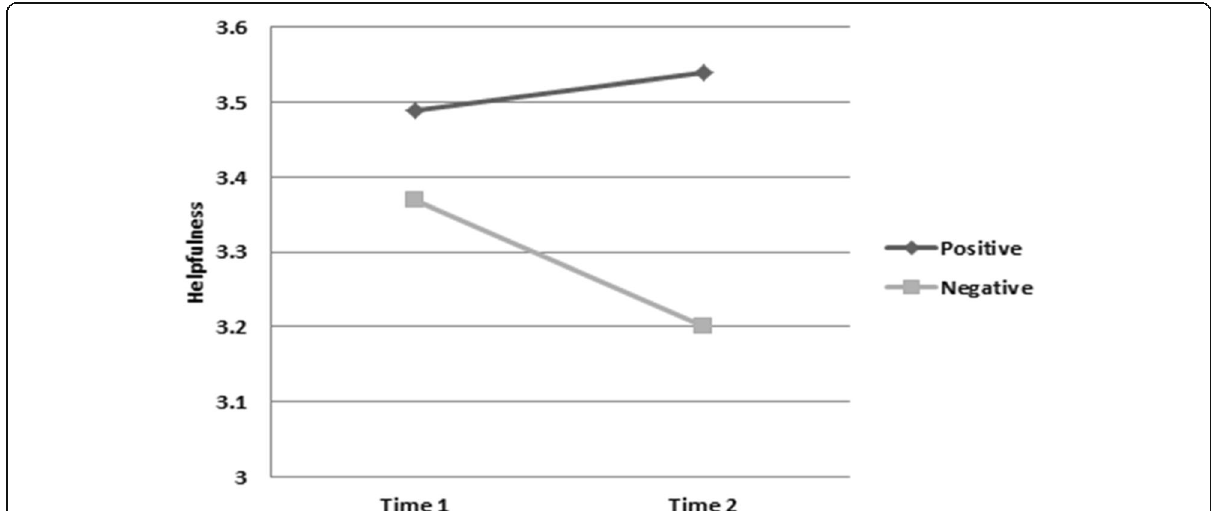
Fig. 10, participants in the positive condition showed increases in trust in the CSP over time while those in the negative condition showed decreases in trust. Inde- pendent samples t-tests indicate that differences between groups were non-significant at pre-label measurement (t (224) = 1.01, p > .05) and significant at post-label measure- ment (t (203) = 2.58, p < .05).